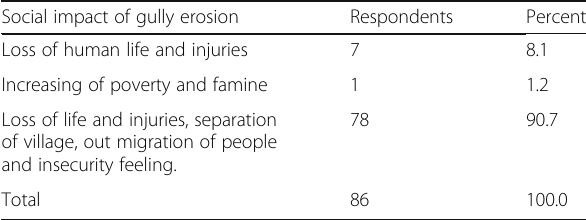
Table 11 Physical effect of gully